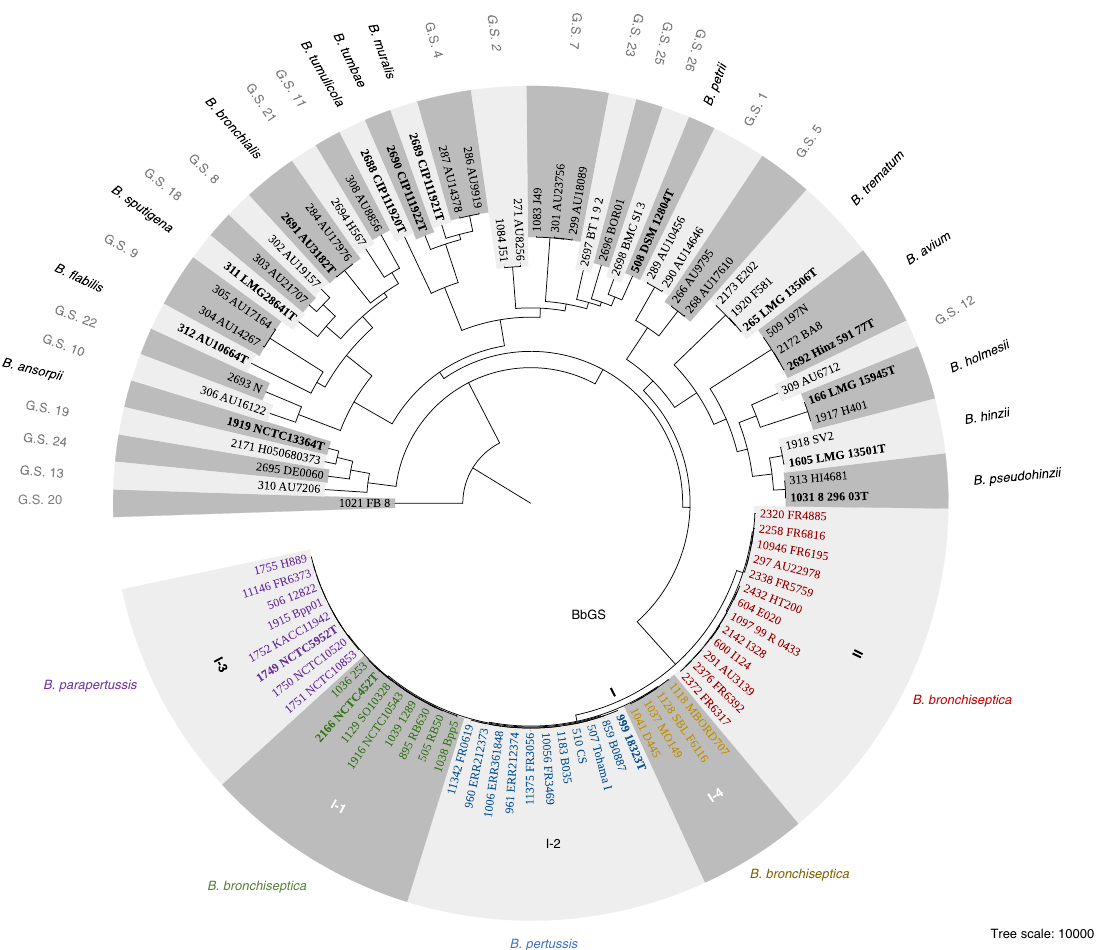
Fig. 1 Phylogenetic analysis of the Bordetella genus. The phylogenetic tree was obtained based on the concatenated multiple sequence alignments of the 1415 core gene sequences from the cgMLST_genus scheme; recombination was accounted for using Gubbins. The tree was rooted on the branch leading to isolate FB-8, which was the earliest branching genome in a phylogenetic analysis that included the external group Ralstonia solanacearum isolate IBSBF1503 (Supplementary Fig. 2). Leaves are labelled with the identi fi er of the isolate in the BIGSdb database, followed by the isolate name. Genomic species are labelled as G.S. An interactive iTOL version of the tree can be accessed at: https://itol.embl.de/shared/1l7Fw0AvKOoCF. Source data are provided as a Source Data fi